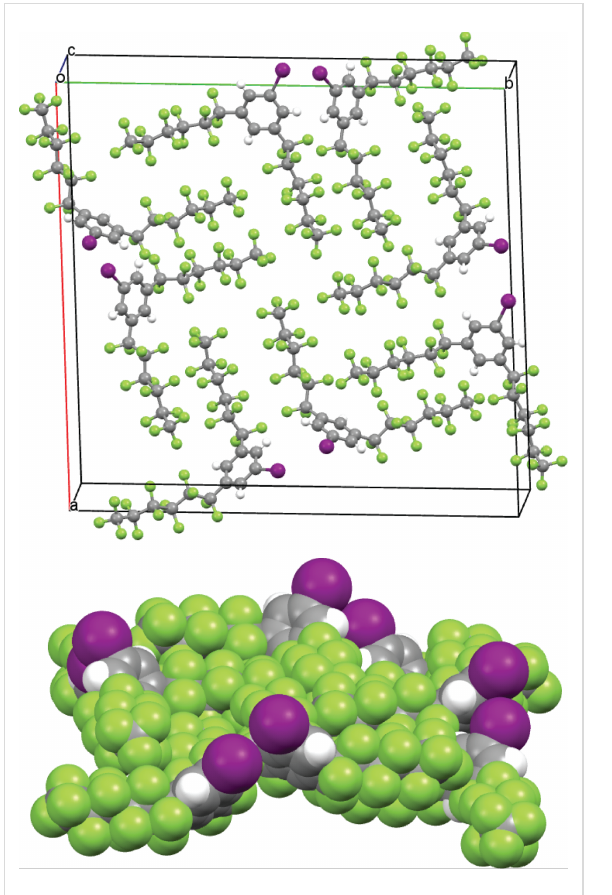
Figure 3: Ball-and-stick and space filling representations of the unit cell of 1,3,5-(R f6 ) 2 C 6 H 3 I.